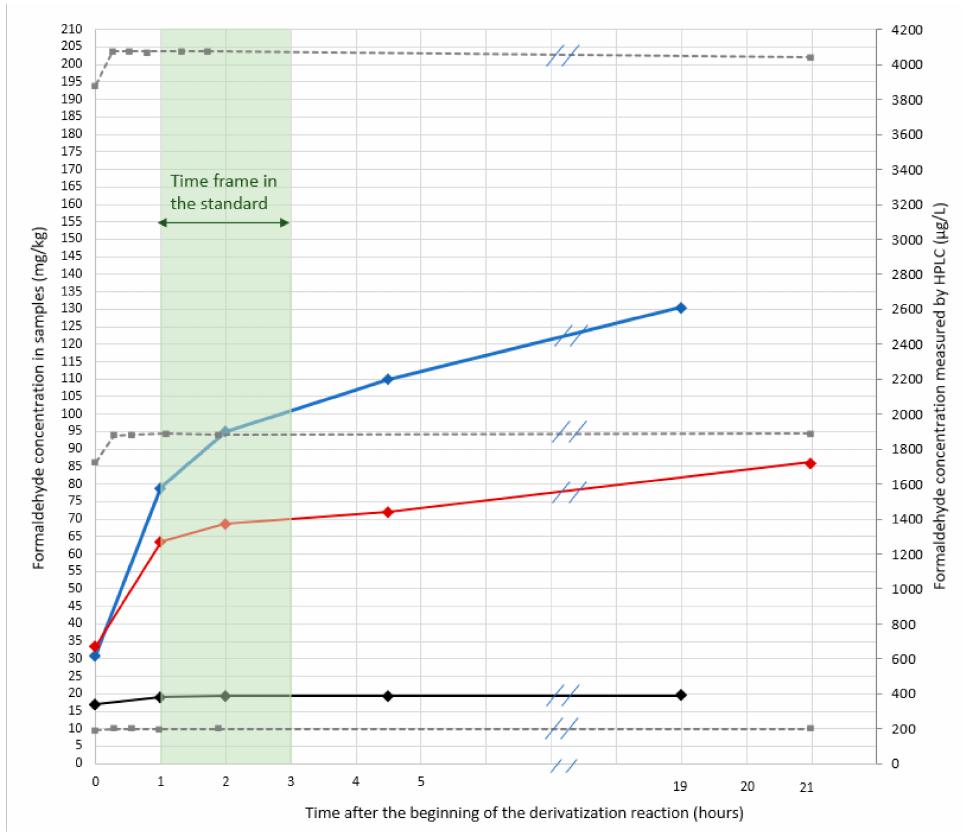
Figure 1. Formaldehyde content over the DNPH derivatization reaction time for lamb leathers tanned with chrome and retanned without resin (in black), with dicyandiamide resin (in blue) or with melamine resin (in red). Samples: prepared, extracted and derivatized following EN ISO 17226-1 standard conditions and analyzed at various time. The green area: the time frame allowed by the standard to analyze samples after their derivatization. Kinetic study of derivatization reaction with quality